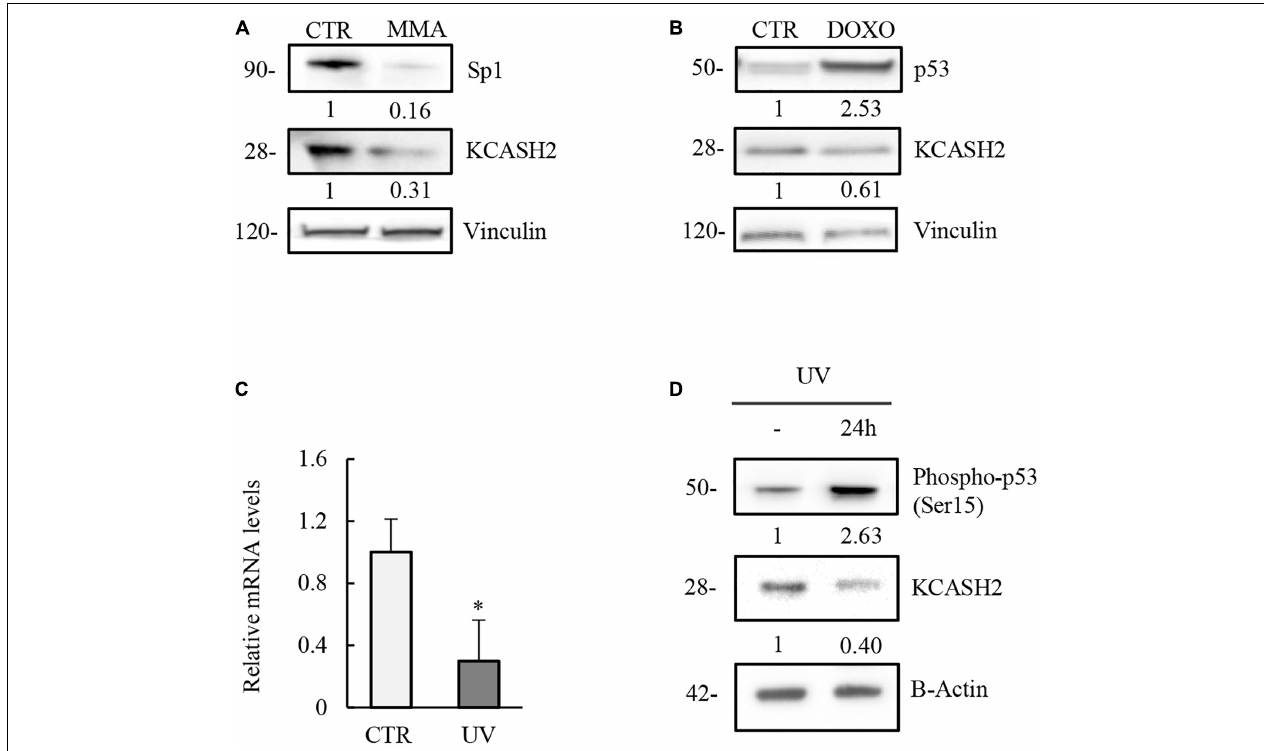
FIGURE 5 | Modulation of KCASH2 expression by p53 and Sp1 is conserved in mouse. (A) Inhibition of Sp1 leads to a decrease of KCASH2 protein levels. MEF cells were treated with MMA (500 nM) for 24 h. Protein lysates were analyzed by Western Blot, using Sp1 and KCASH2 antibodies. Anti-vinculin was used as loading control. (B–D) p53 downregulates KCASH2 expression. (B) MEF cells were cultured with DOXO (5 µ M) for 10 h, then cells lysates were analyzed by Western blot. Vinculin was used as loading control. (C,D) MEF cells were exposed to UV-C light and collected after 24 h. Then, RT-qPCR analysis was performed (C) . Endogenous KCASH2 mRNA levels were normalized on GAPDH and HPRT, and represented as fold-induction on CTR. Data are representative of three experiments and presented as mean ± SD. ∗ p < 0.05. Endogenous KCASH2 protein and p53 activation (D) were analyzed by Western blot and revealed with antibodies against KCASH2 and Ser15 phosphorylated p53. Anti- β -actin is shown as loading